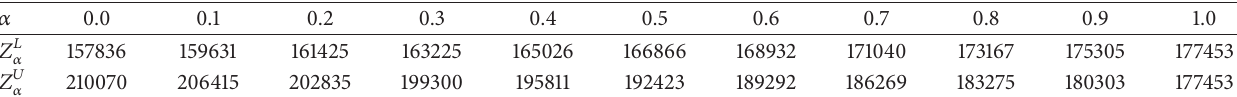
Table 9: The 𝛼 -cuts of minimum total cost at 11 𝛼